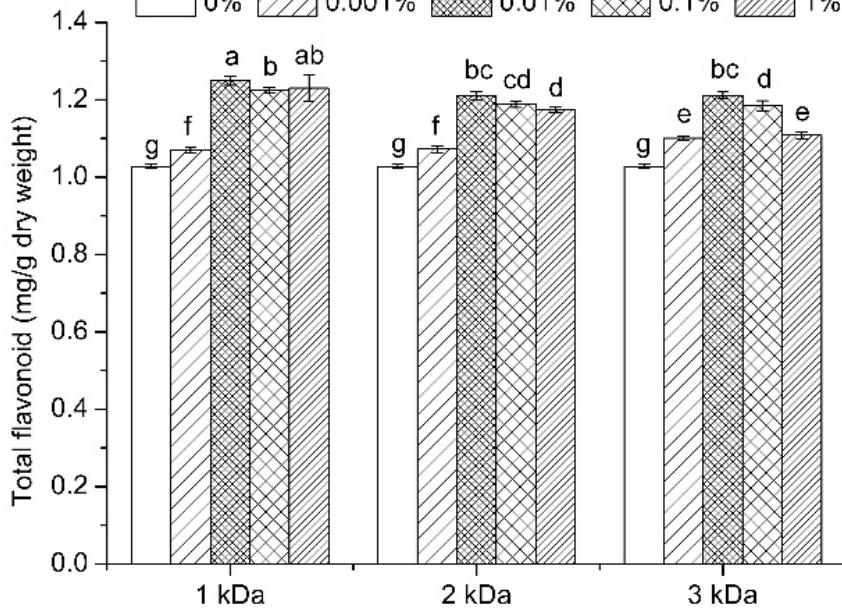
Figure 3. Total flavonoid content of soybean sprouts under different chitooligosaccharide treatments. The treatments were conducted with chitooligosaccharides of three molecular weights (1, 2, and 3 kDa) at four different concentrations (0.001 to 1%). The control treatment (0%) included the same solutions without chitooligosaccharides. Vertical bars represent the standard error of three replicates. Different letters indicate statistically significant difference ( p < 0.05).